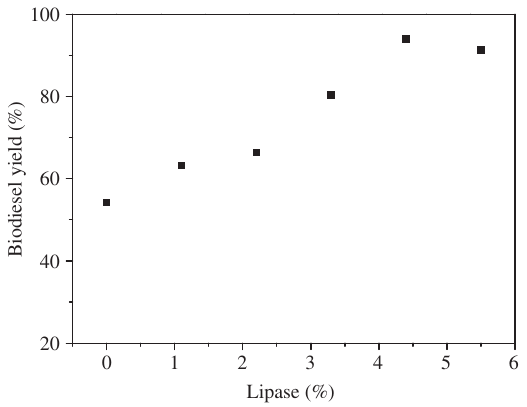
Figure 2 Effect of lipase concentration on biodiesel yield [reaction conditions: w (molar ratio of water to surfactant) 3.5, molar ratio 0 (methanol/oil) 9, time 16 h, temperature 40 ° C, stirrer speed 250